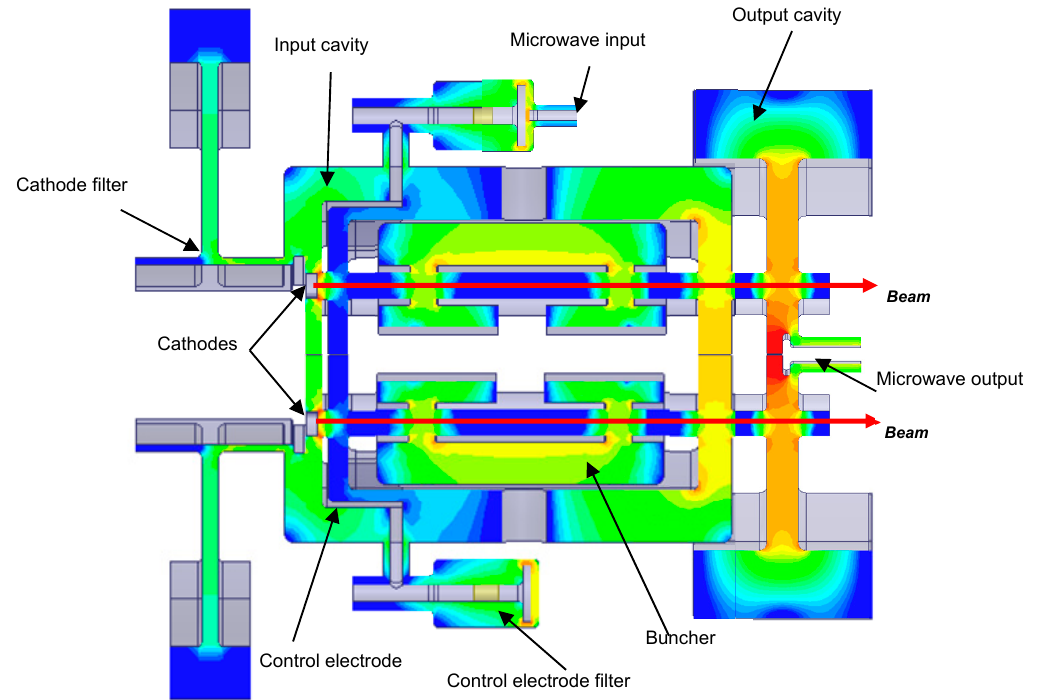
Figure 22. Electrodynamic model of a resotrode (using HFSS code) .